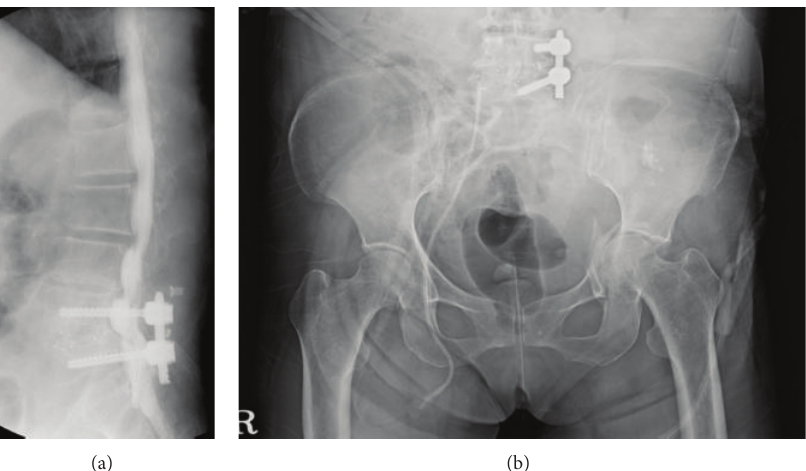
Figure1: (a)Myelography taken afteremergency careshowing instrumenton L4-5. (b)Radiograph taken 2days after seizureepisodeshowing left acetabular fracture with medial displacement of femoral head.